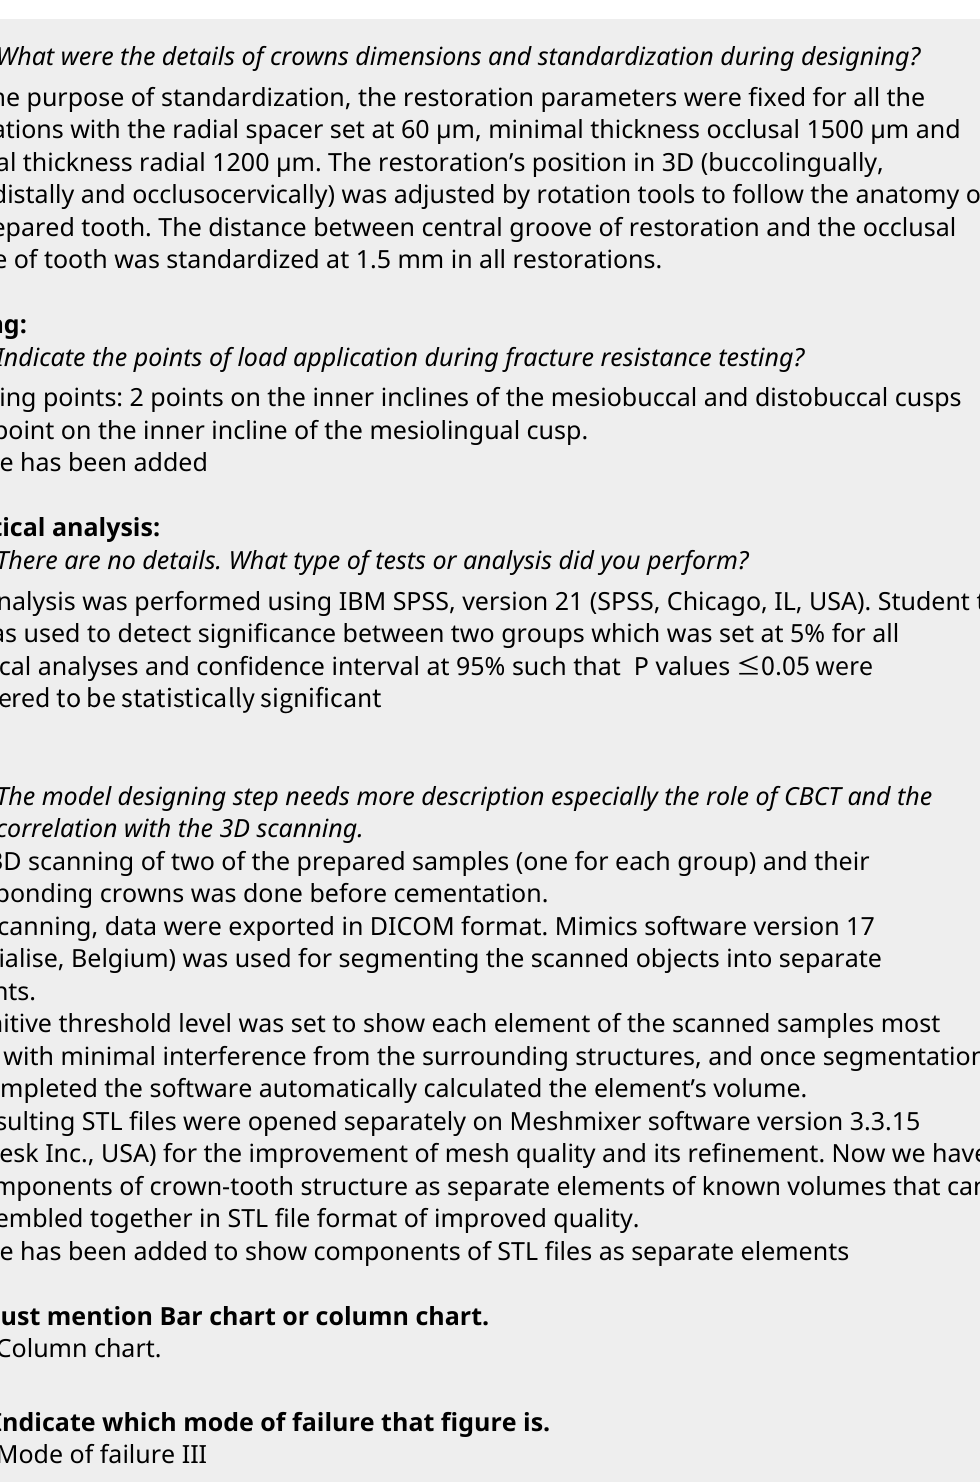
Fig 4: Indicate which mode of failure that figure is. Mode of failure III